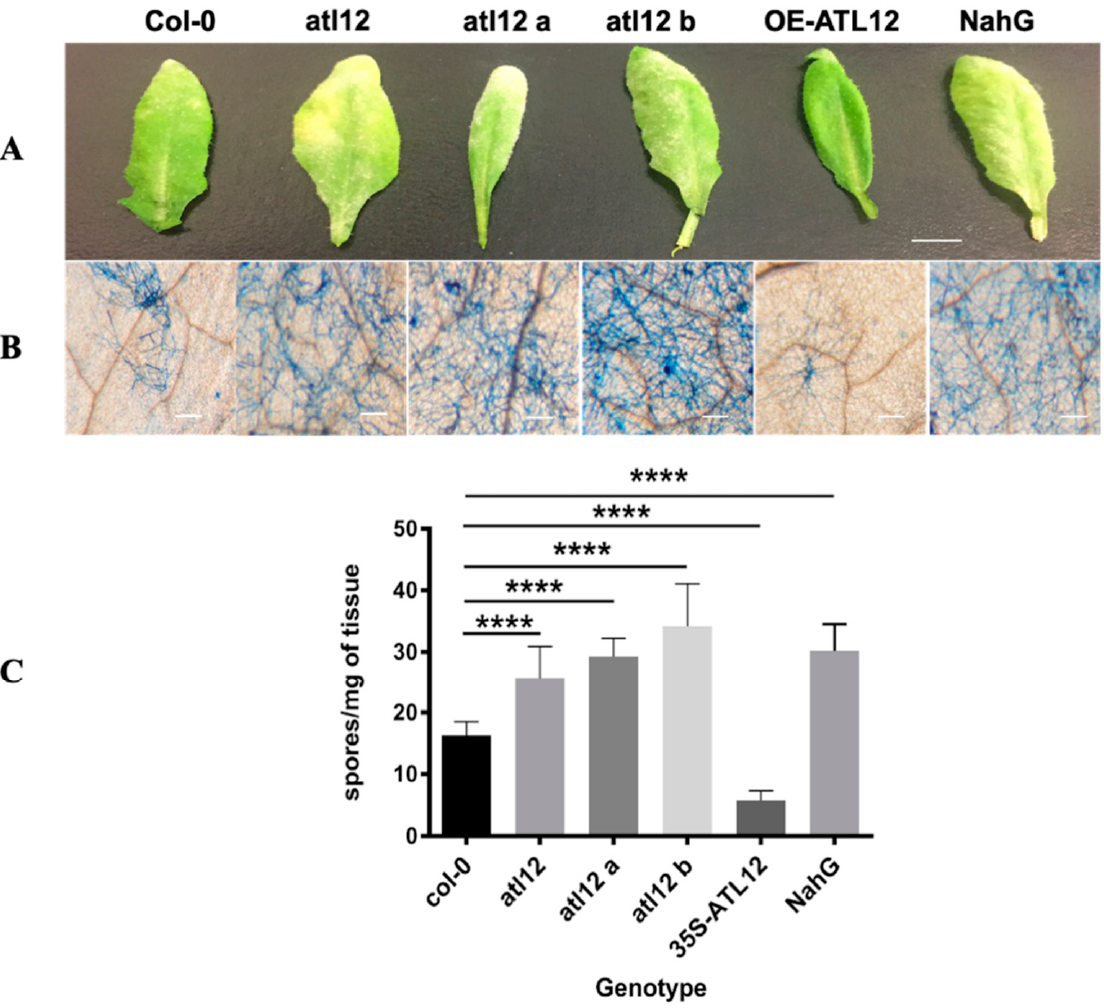
Figure 5. Phenotypic analysis of Col-0 wild-type (WT), atl12 mutants and overexpression (OE) 35S:ATL12 plants in response to powdery mildew infection. ( A ). Leaf appearance of wildtype, atl12 mutants, overexpression ( 35S:ATL12 ) seedlings and NahG transgenic plants (highly susceptible to fungal infection) 7d after powdery mildew infection. The white scale bar indicates 1 mm. ( B ). Trypan blue staining of the fungal structures on leaves 7days after fungal infection. ( C ). Quantitative phenotypic analysis of each seedling. One-way ANOVA followed by Tukey’s test was used to analyze the differences among treatments. Experiments were repeated three times. **** indicates p < 0.0001.